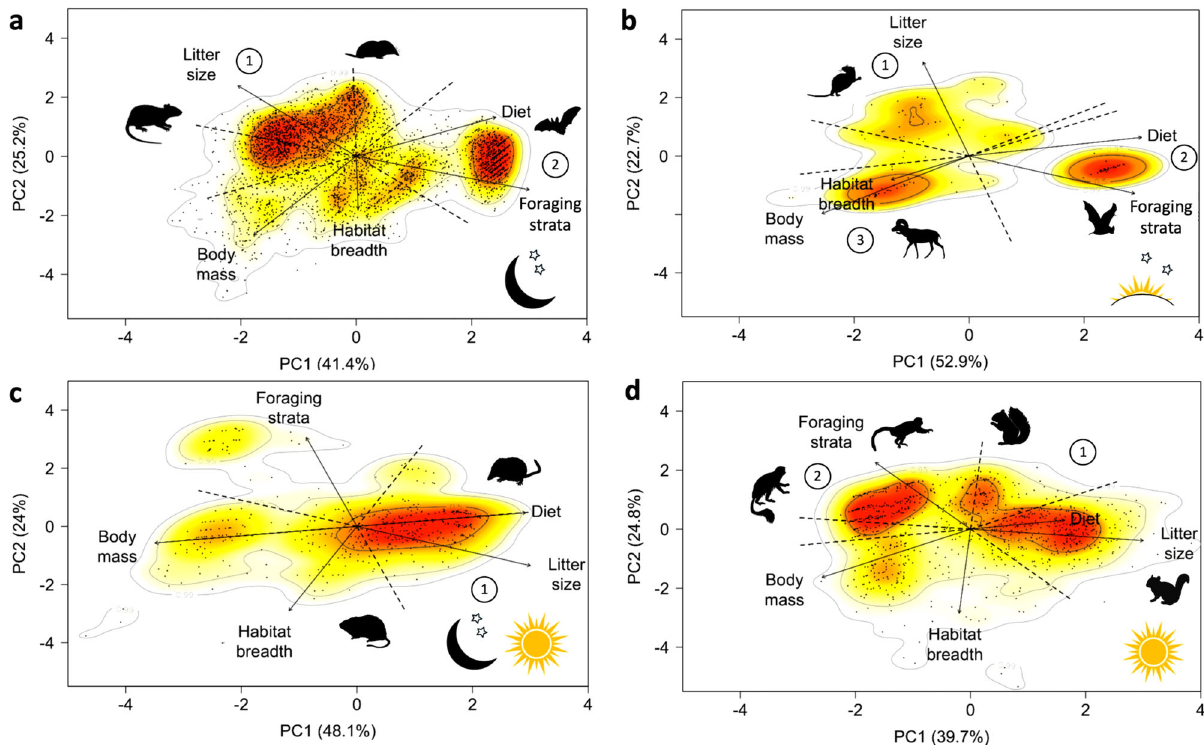
Fig. 1 Ecological strategy surfaces associated with mammals occupying different diel niches. a Nocturnal ( n = 3580, moon and stars silhouette), b crepuscular ( n = 126, sunrise/sunset and stars image), c cathemeral ( n = 467, moon, stars and sun image) and d diurnal ( n = 931, sun image). For each diel niche, projections show the species (dots) on the surface de fi ned by principal component axes (PC) 1 and 2. Solid arrows indicate the direction and weighting of vectors representing the fi ve continuous traits analysed, and thus represent the major gradient of each trait (Supplementary Tables 1 and 2 for trait variance and loadings). Percentage values represent the proportion of the total variation explained by each PC. The colour gradient speci fi es regions of highest (red) to lowest (white) occurrence probability of species across the ecological strategy, with contour lines indicating 0.5, 0.95 and 0.99 quantiles. Thus, red regions correspond to functional hotspots and circled numbers denote the hotspots in each diel niche, as described in the main text. Silhouettes represent species characterising the hotspots. Large hotspots display two silhouettes, representing species at the hotspot extremes (silhouettes were freely downloaded from PhyloPic www.phylopic.org, under CC0 1.0 Public Domain Dedication and from Adobe Stock Images under Standard